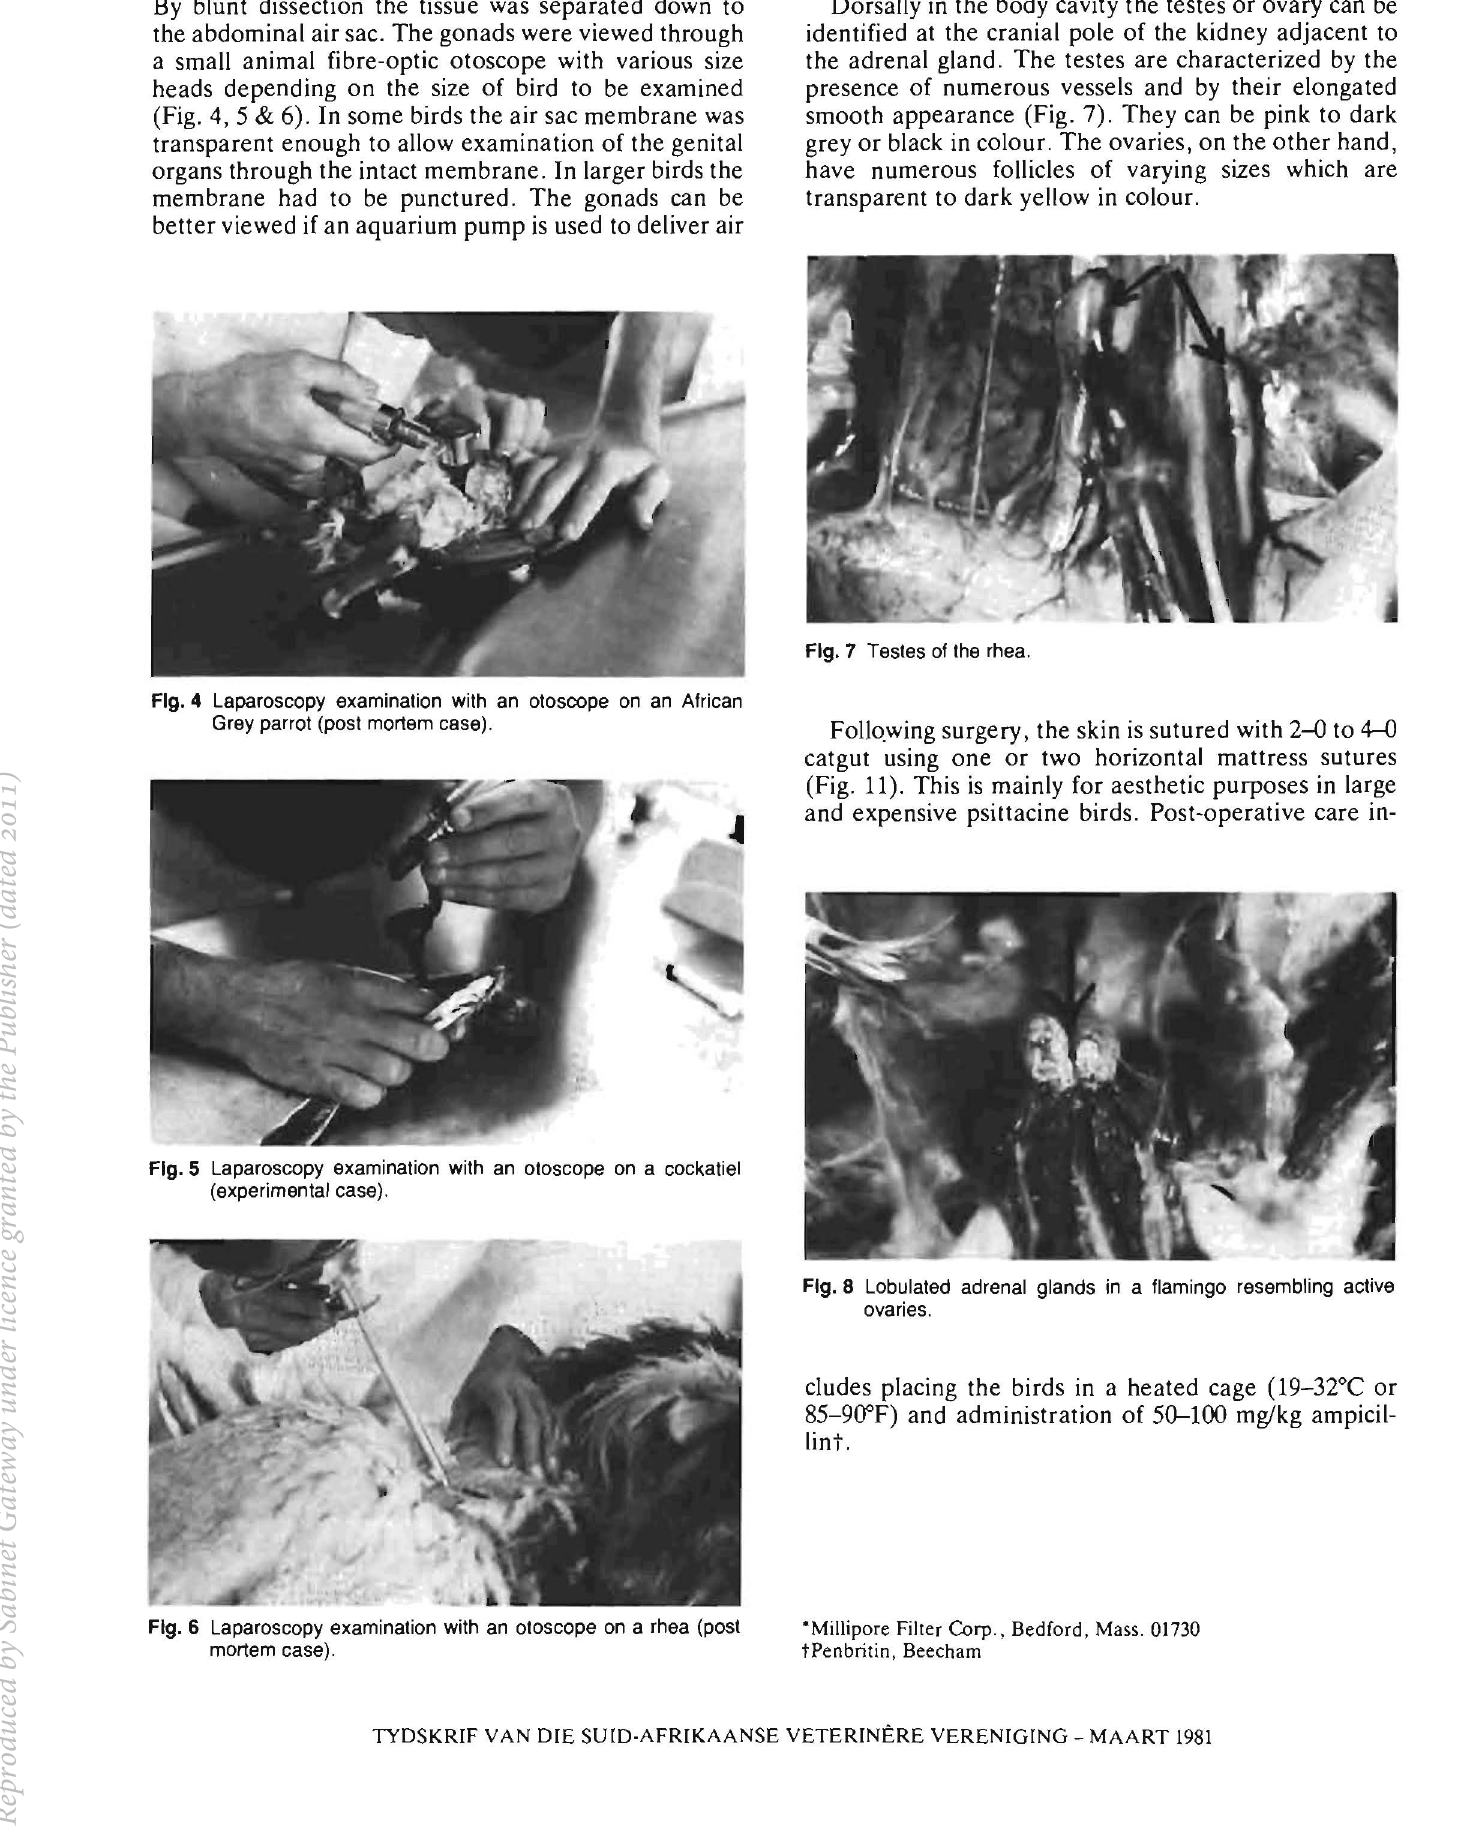
Fig. 6 Laparoscopy examination with an otoscope on a rhea (post mortem case).